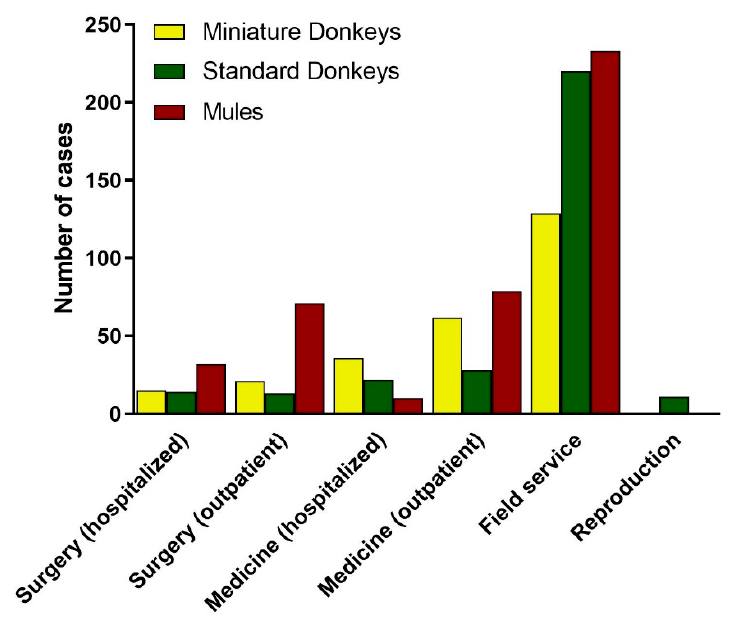
Figure 10. Distribution of Donkey and Mule Caseload from 2008 to 2017 across the Equine Services. Standard donkeys (green), miniature donkeys (yellow), and mules (red).